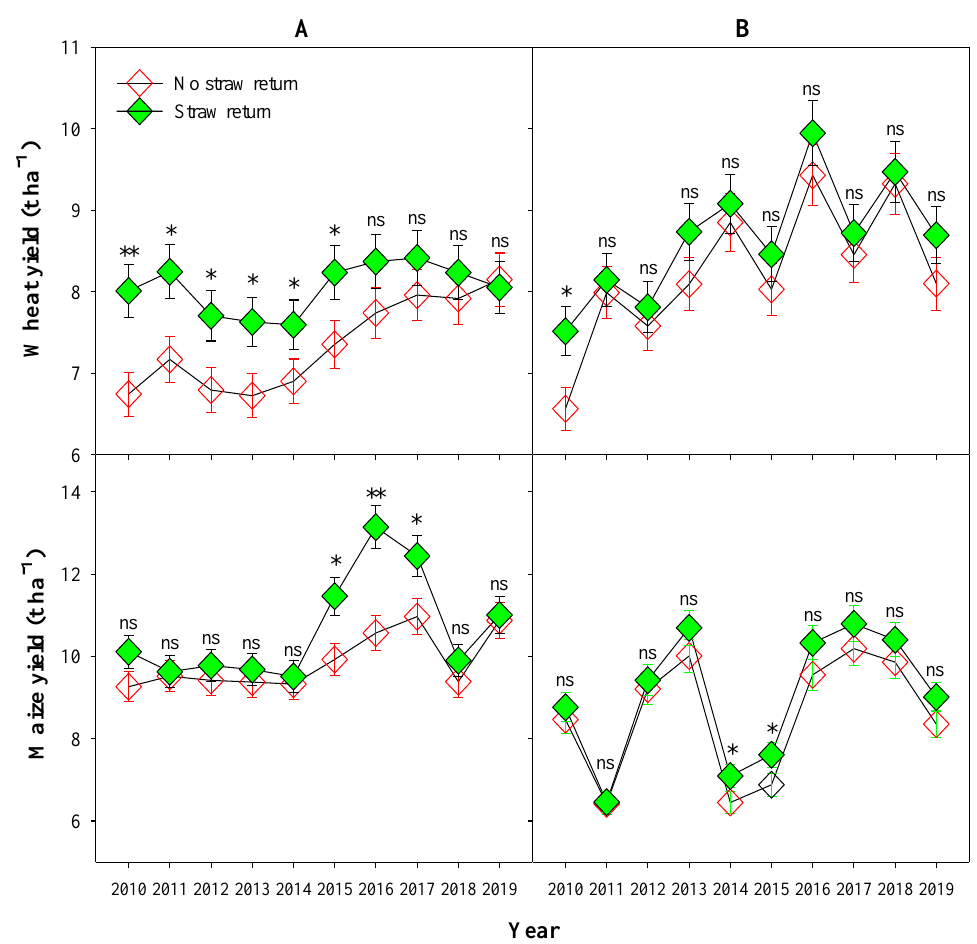
Figure 7. Wheat and maize yields over time under no straw return and straw return practices at the Tai’an ( A ) and Longkou ( B ) experimental sites. ** significant difference at 0.01 level; * significant difference at 0.05 level; ns: not significant difference.